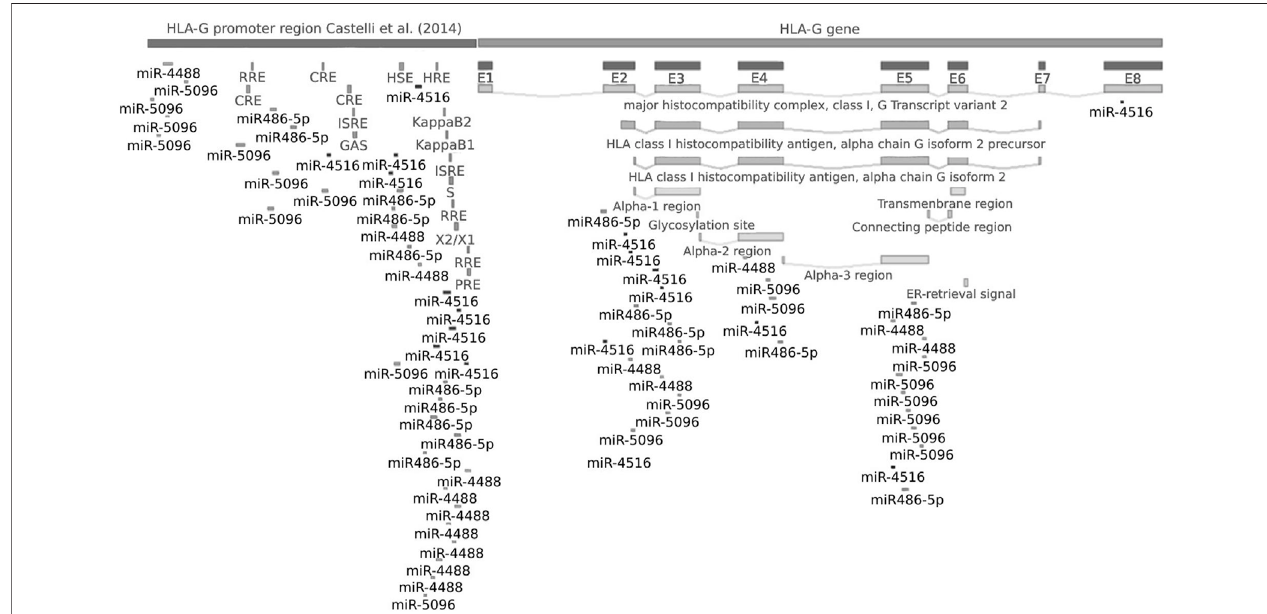
FIGURE2| HLA-G genebindingsitesforhsa-miR-5096,hsa-miR-4516,hsa-miR-486-5p,andhsa-miR-4488.ThemiRNAcascadeinthe fi gureindicatesputative binding sites in the target gene. Note: the promoter region was mapped and analyzed as described by Castelli et al. (2014). Coding sequence was considered as described by GenBank ( < https://www.ncbi.nlm.nih.gov/nuccore/NG_029039.1 > ), and exon 8 is considered as the HLA-G 3 ′ UTR [5].